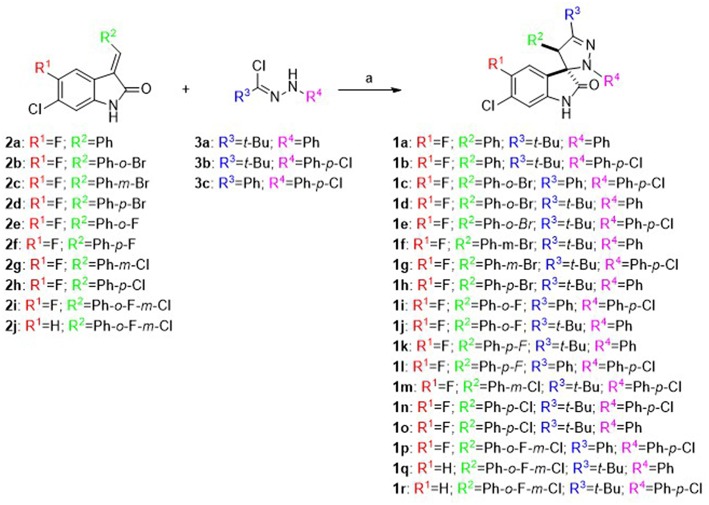
Synthesis of spiropyrazoline oxindoles 1a–r: Reagents and conditions: (a) Et3N, CH2Cl2, rt, 16–24 h.